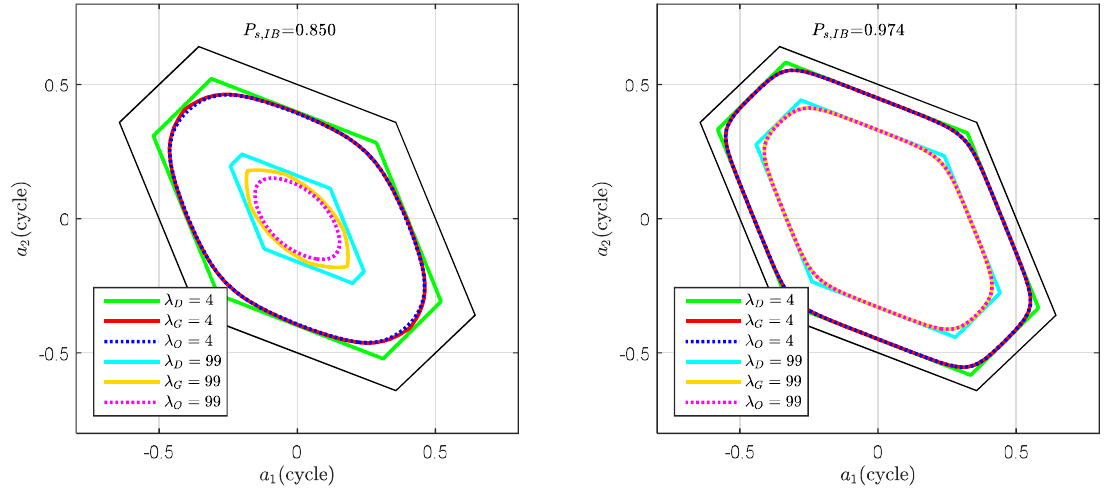
Figure 3 . Comparison of the GDT3 acceptance region with the difference test and OIA acceptance region.